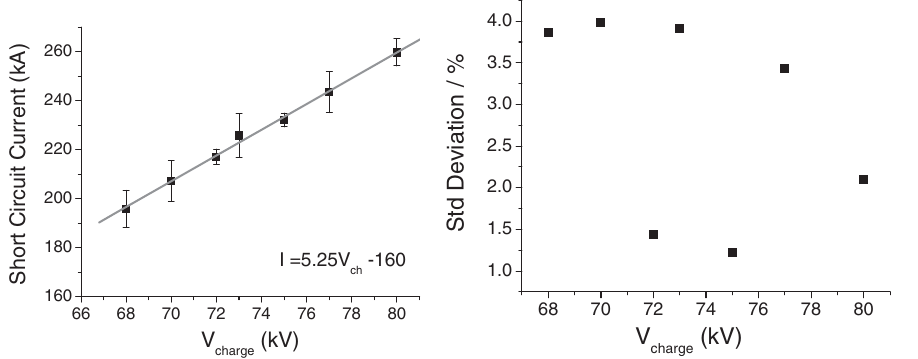
FIG. 3. Plot for short circuit loads showing (left) variation of mean load current and (right) variation of standard deviation as a function of machine charge